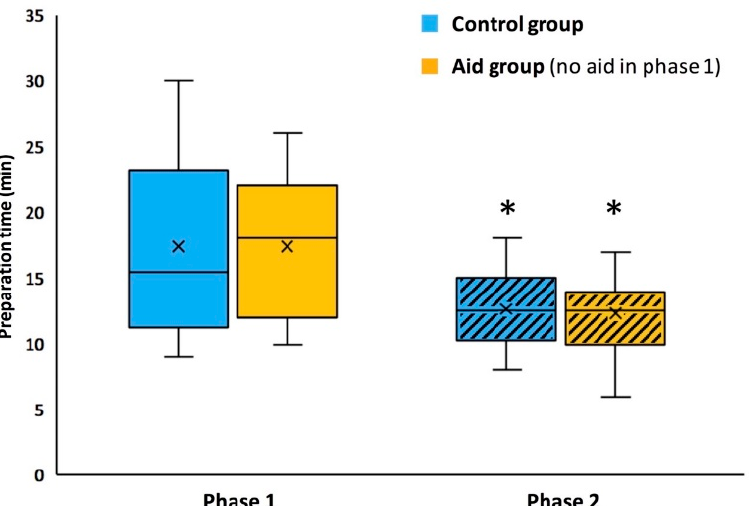
Figure 3. Durations of the anesthetic preparation by residents of control group (blue boxes) and aid group (yellow boxes), in phase 1 (plain filling) and phase 2 (hatched filling). Residents in the aid group had a cognitive aid in phase 2, but not in phase 1. n = 16 in each group. *, significant difference with the same group in phase 1.